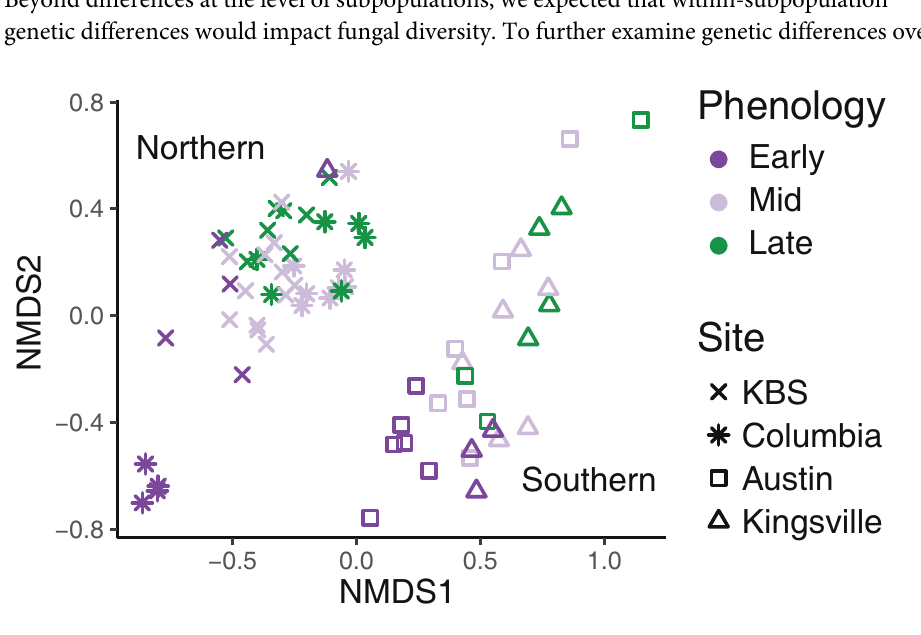
significant site:sampling date interaction term indicates that succession differs across sites, but additional samples may be needed to fully understand this pattern.